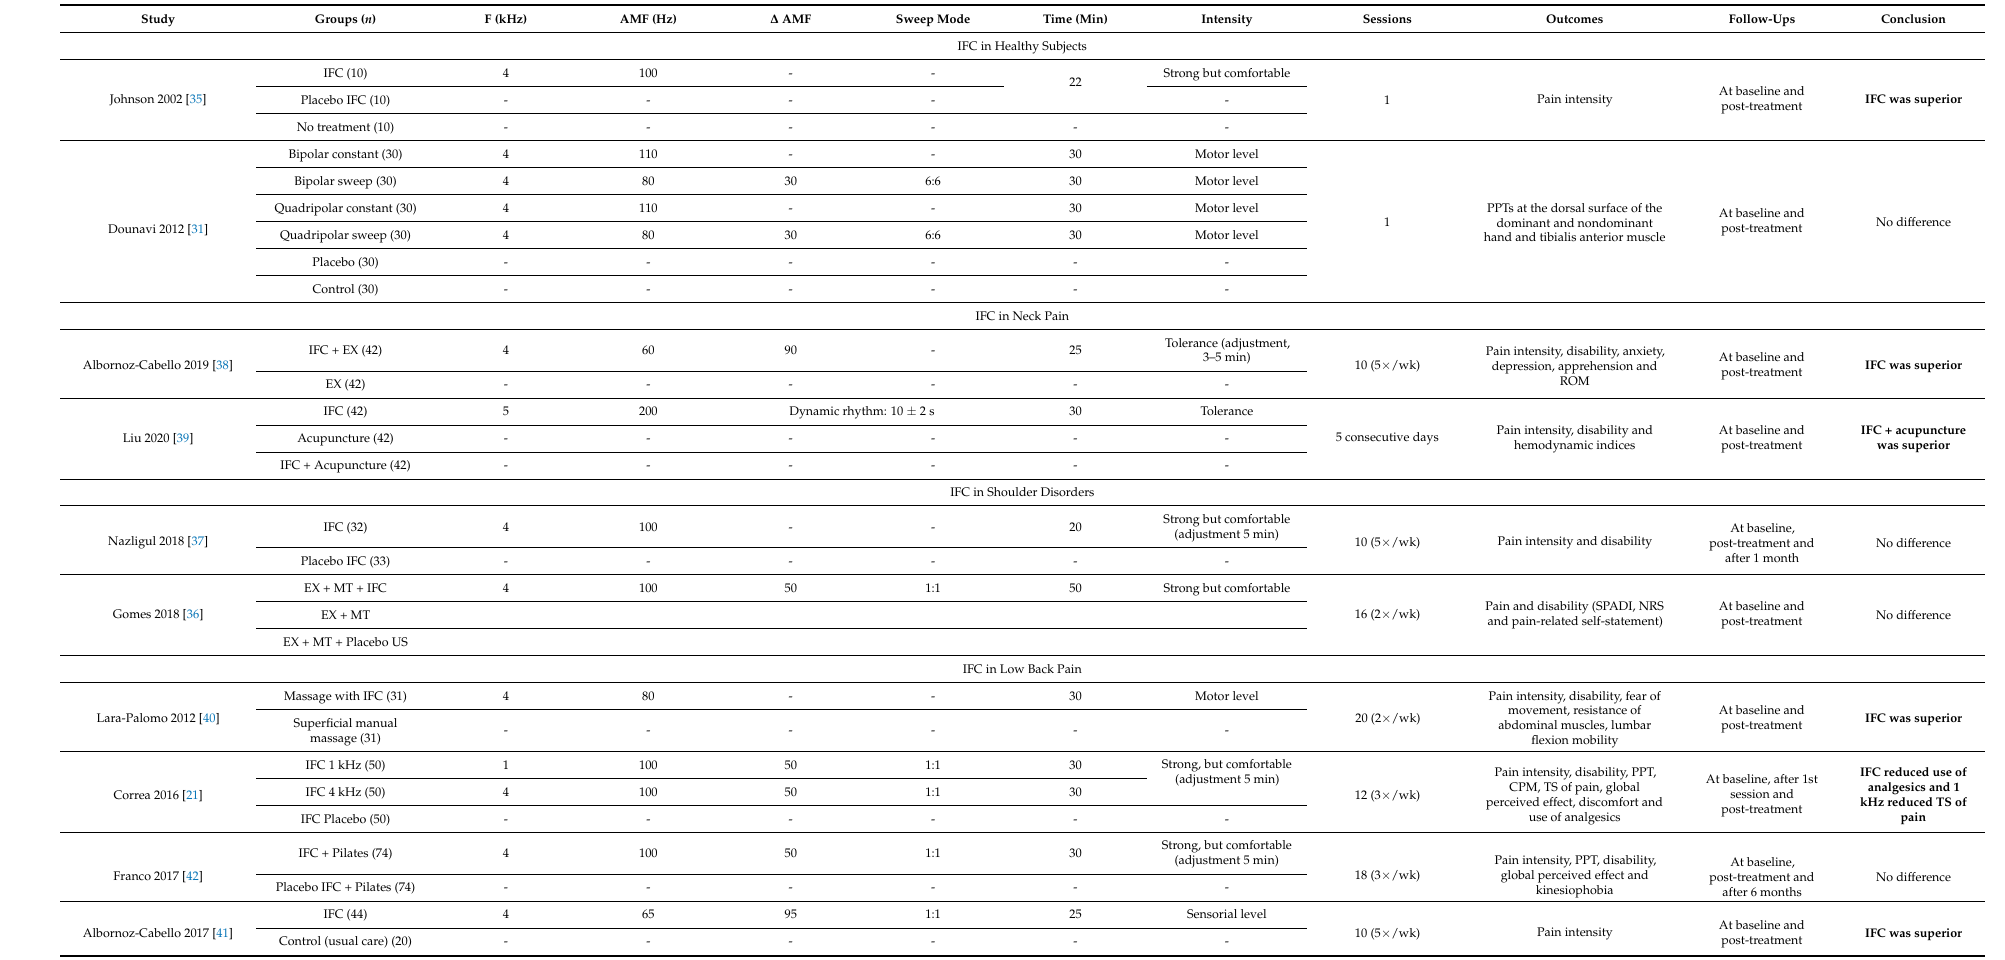
Table 1. Randomized clinical trials of the effectiveness of IFC